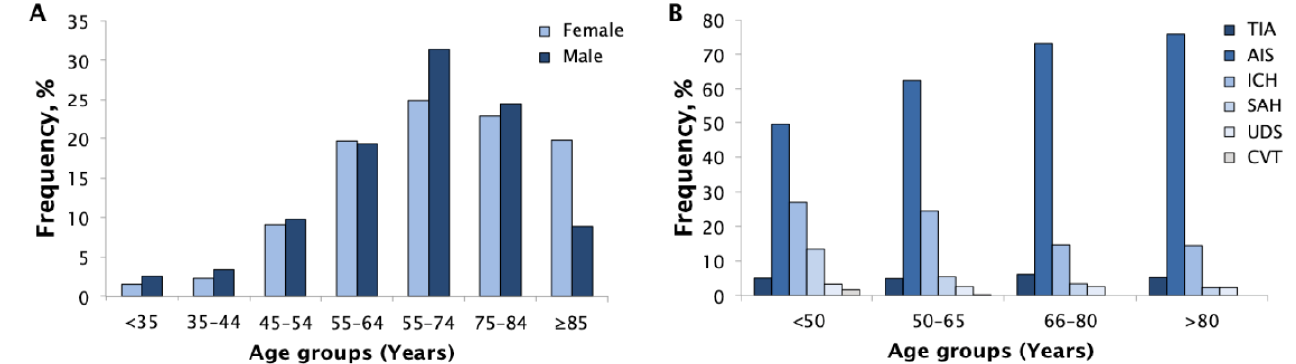
Figure 2. Proportions by age group and sex ( A ) and proportions by age groups and stroke subtypes ( B ). AIS, acute ischemic stroke; CVT, cerebral venous thrombosis; ICH, intracerebral hemorrhage; SAH, subarachnoid hemorrhage; TIA, transient ischemic attack; UDS, undetermined stroke. Table 1 describes the demographic data, vascular risk factors, and complications by stroke subtype (the three patients with CVT were excluded from this analysis). The most prevalent vascular risk factor was systemic arterial hypertension, reaching up to 80%. In addition, diabetes mellitus was present in 50% of patients with AIS. Dyslipidemia was found in 68% among 454 (33.4%) patients with plasma lipids measured or who were under medication for hypercholesterolemia or hypertriglyceridemia. In patients with AIS, the most prevalent heart risk factors were atrial fibrillation (11.3%), ischemic heart disease (7.7%) and chronic heart failure (2.6%). Chronic kidney disease was observed in 11% of patients with ICH and 9% in AIS. With regard to hospital stay, most (72%) of the patients with TIA were discharged from the ER. In-hospital infections (pneumonia, urinary tract infections, and sepsis) were identified in around 25% of patients, depending on the stroke subtype. IMV was required in 262 (19.3%) patients, but 190 (72.5%) received IMV at the internal medicine wards, and 70 (26.7%) at the ER, whereas only 22 (8.4%) were admitted to the ICU. Table 1. Baseline clinical and demographic characteristics and in acute stroke patients.